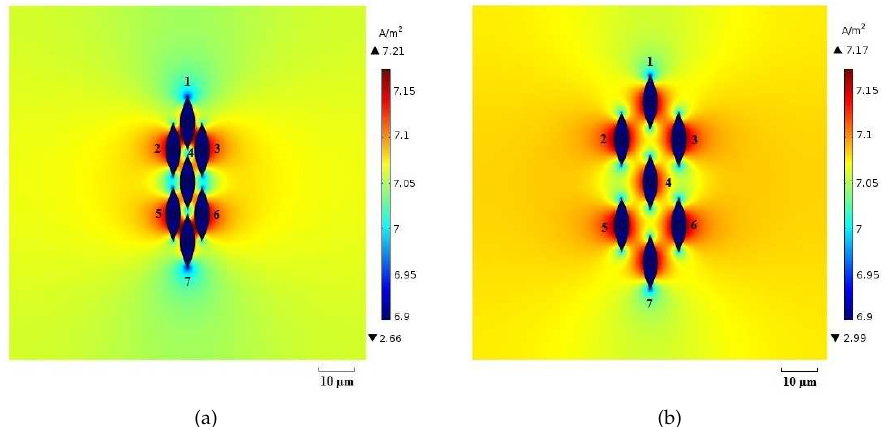
Figure 13. Current density distribution (log scale) for ( a ) packed system and ( b ) sparse system at the time instant 10